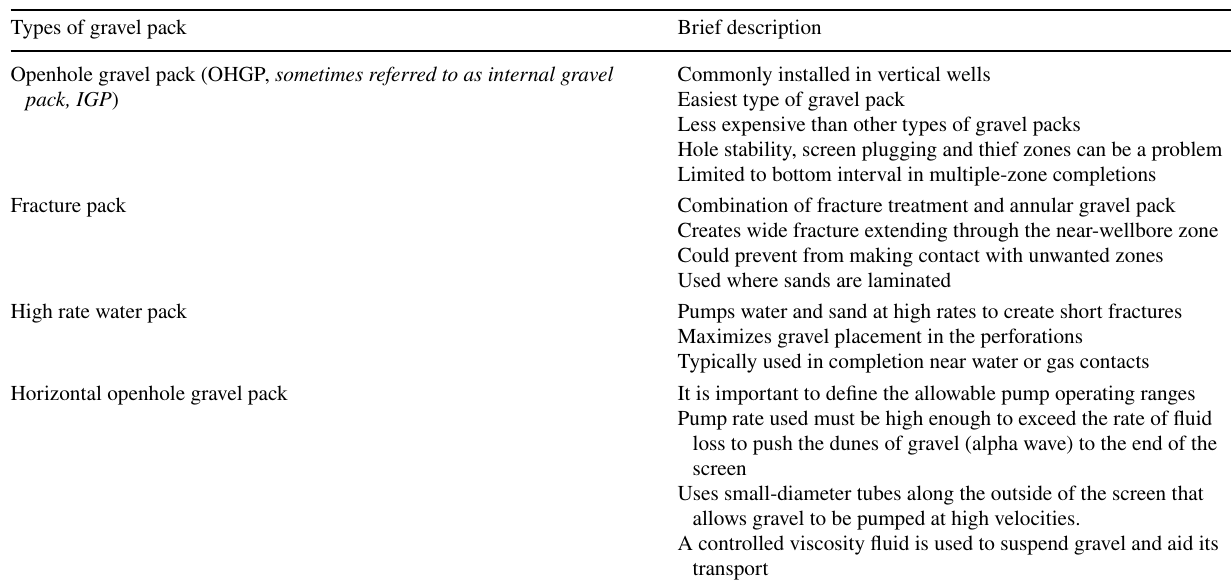
Table 4 Types of gravel packs (Deghani 2010) Types of gravel